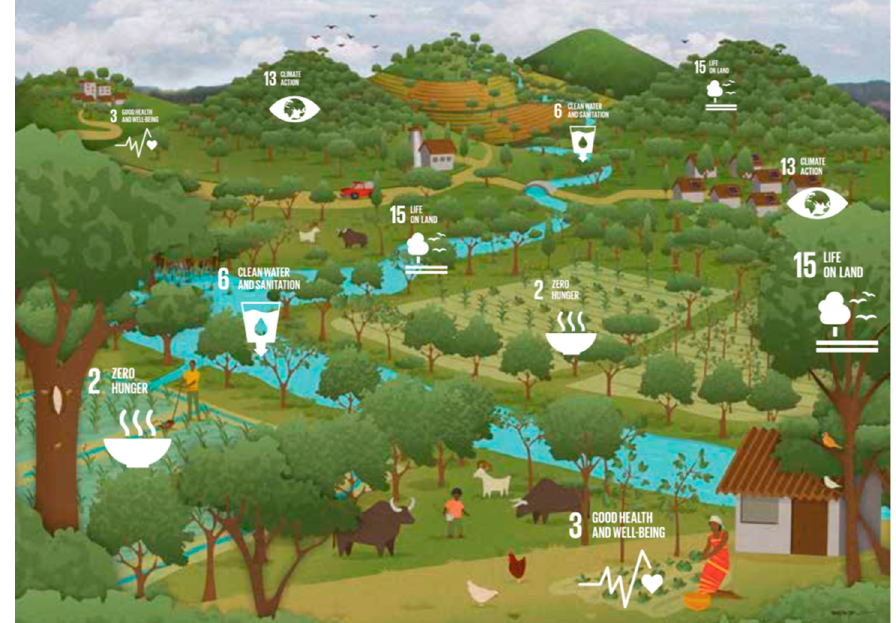
Figure 1. Key sustainable development goals embedded in Forest and Landscape Restoration activities (adapted from: Thaxton et al. [28] with permission from Landscapes for People, Food and Nature Initiative, 2015: Washington, DC, USA).